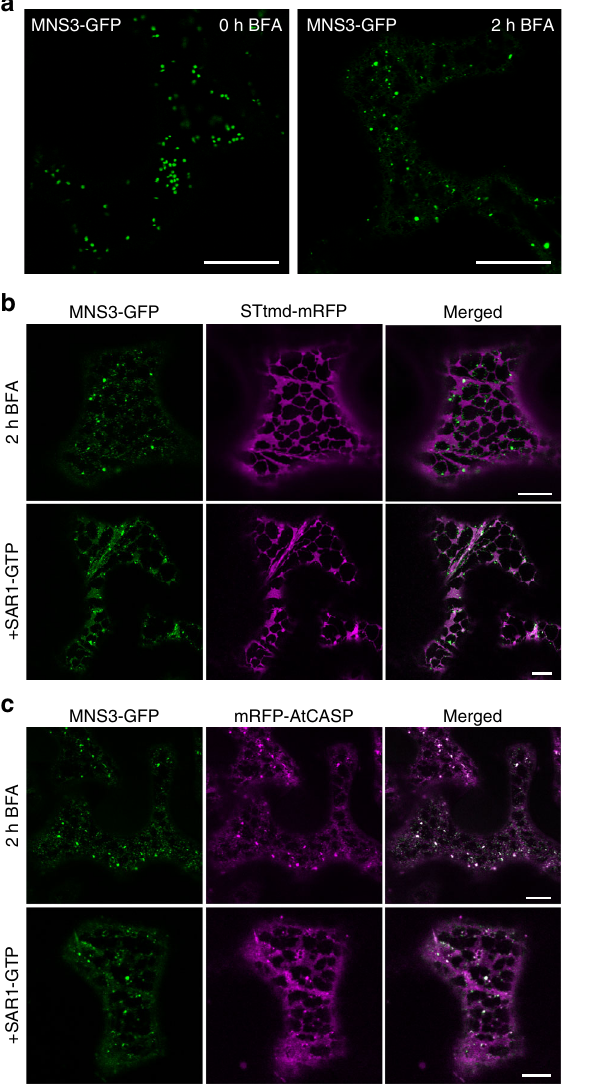
Fig. 4 Distinct cis -Golgi membrane proteins respond differently to BFA. Fluorescent protein fusions were transiently expressed in N . benthamiana leaf epidermal cells and observed 2 dpi on a confocal microscope. Images show the subcellular localization of ( a ) MNS3-GFP, ( b ) the Qa-SNARE GFP- AtSYP31, ( c ) the golgin GFP-AtCASP, and ( d ) the K/HDEL recycling receptor AtERD2-GFP before and after 1h BFA treatment. Scale bars = 10 µ m localization of the fusion proteins on puncta (Supplementary Fig. 2a). In comparison, GFP-AtCASP highlighted a mixture of ER and punctate structures of varying size after 1 h BFA treat- ment (Fig. 4c). In contrast, the GFP-fused cis -Golgi membrane marker AtERD2, a recycling receptor for K/HDEL tetrapeptide- containing ER-resident proteins 42,43 , was fully absorbed into the ER upon BFA treatment (Fig. 4d). Co-expression of MNS3-GFP with MNS1-mRFP showed that MNS1-mRFP, similar to AtERD2, was redistributed to the ER, whereas MNS3-GFP mainly remained on puncta as usually (Supplementary Fig. 2b). All in all, our data are in agreement with previous observations that distinct cis -Golgi membrane proteins behave very differently in the pre- sence of BFA and that MNS3 belongs to the small group of cis - Golgi membrane proteins that after Golgi disassembly pre- dominantly remain on membrane structures that have previously been termed Golgi remnants 38 or GECCO 40 .